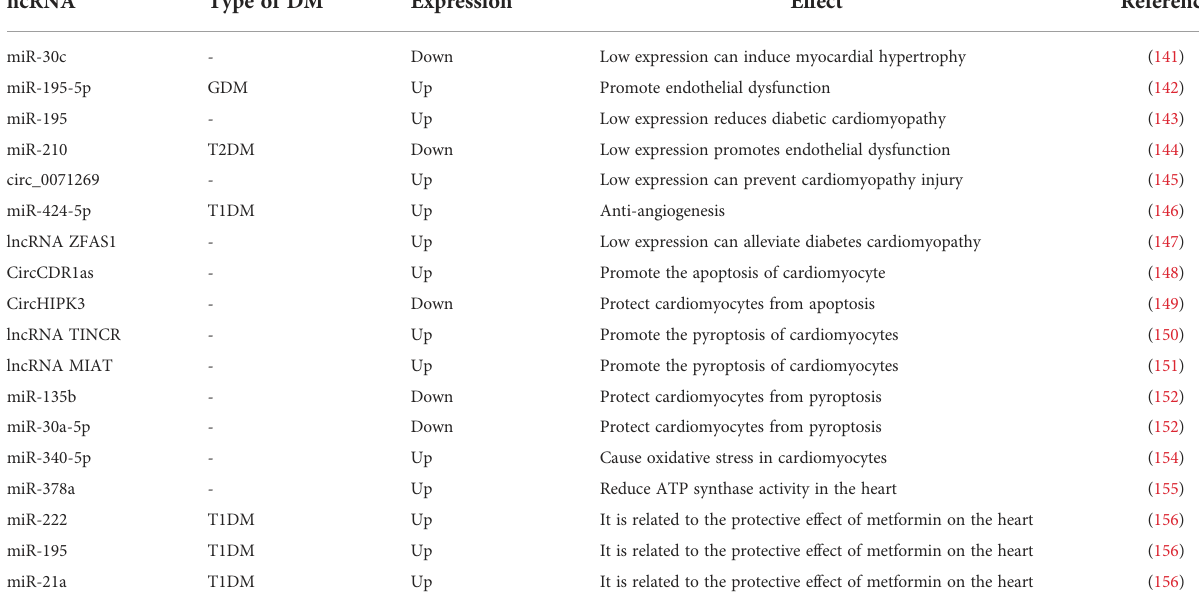
TABLE 4 The role of ncRNAs in diabetic CVD. ncRNA Type of